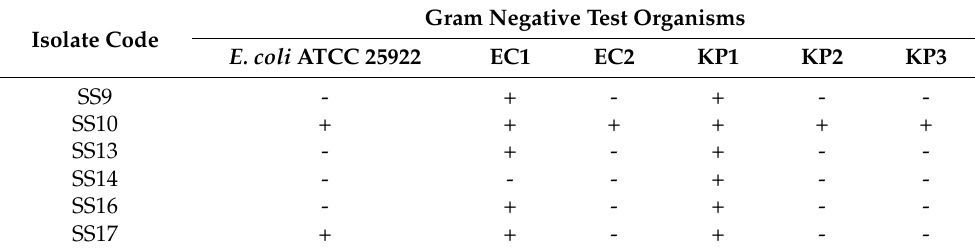
Table 2. Primary screening against Gram negative test organisms. Isolate Code